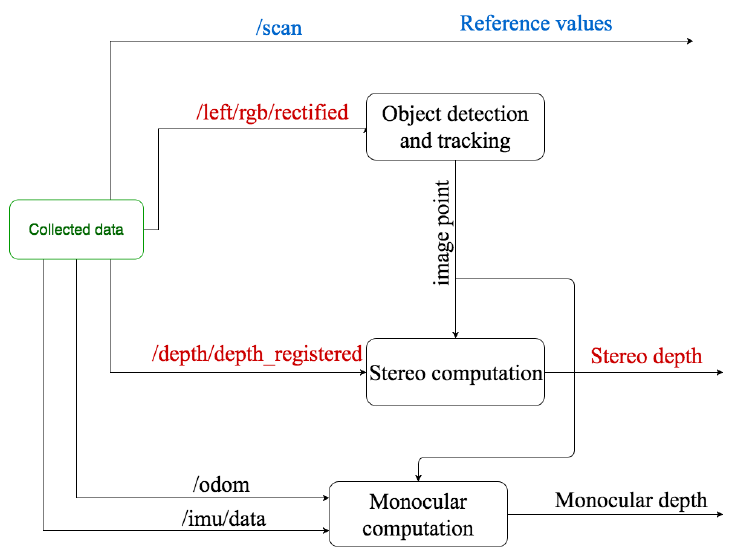
Figure 4. An example of experiment setup.